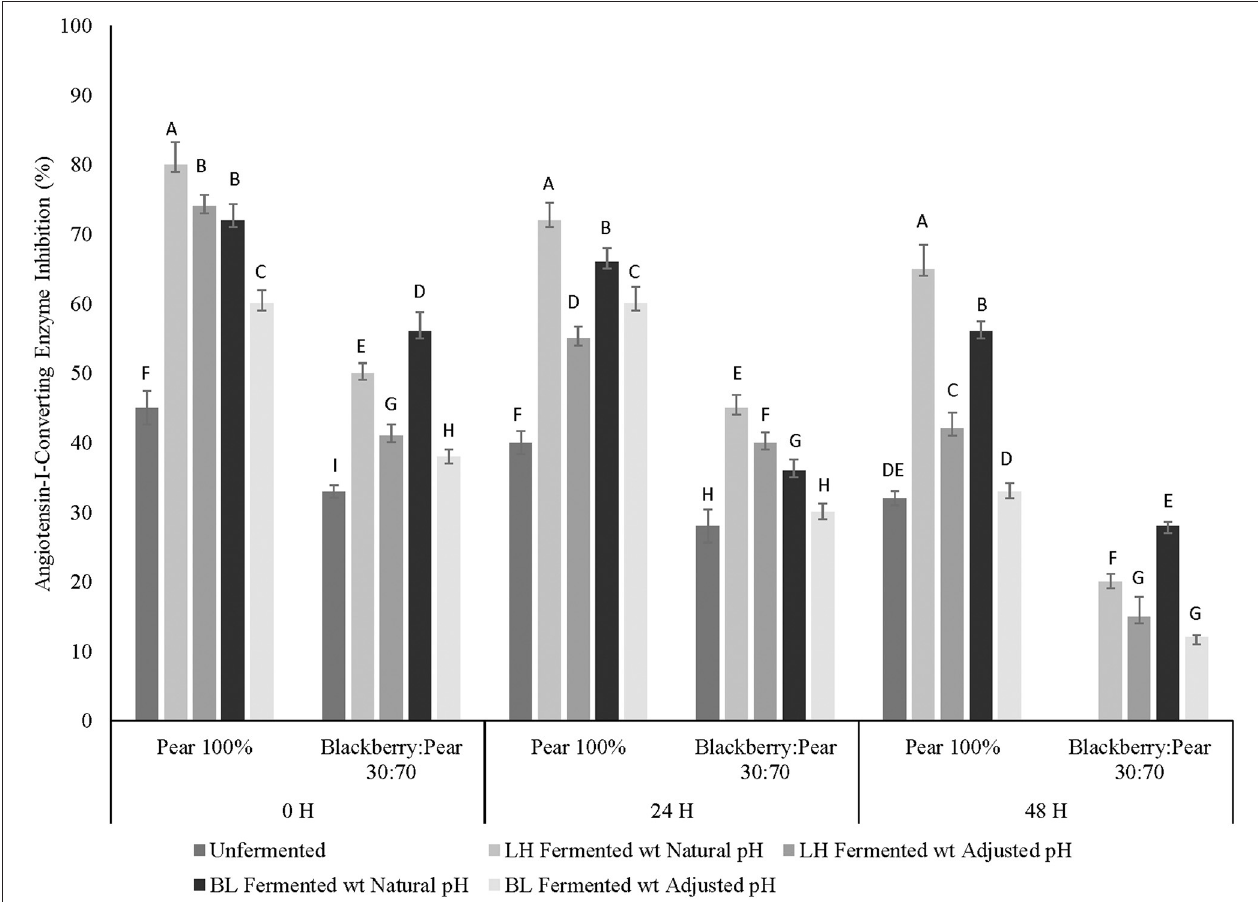
FIGURE 3 | Anti-hypertensive property relevant angiotensin-I-converting enzyme (ACE) inhibitory activity of Bartlett pear (100%), blackberry: pear (30:70) after fermenting with Lactobacillus helveticus (LH) and Bifidobacterium longum (BL) at 0, 24, and 48h time points. Fermented and unfermented blackberry extracts (100%) did not show any ACE inhibitory activity. Different uppercase letters represent statistically significant ( p ≤ 0.05) differences in ACE inhibitory activity between fruit sample extracts × fermentation treatment interactions separately at all 3 fermentation time point.